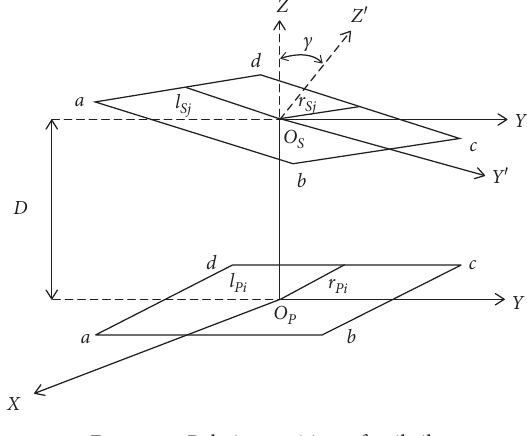
Figure 7: Relative position of coil